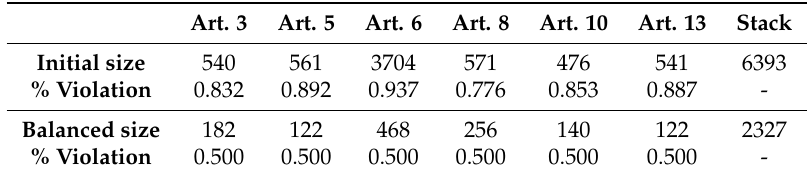
Table 1. Datasets sizes and labels